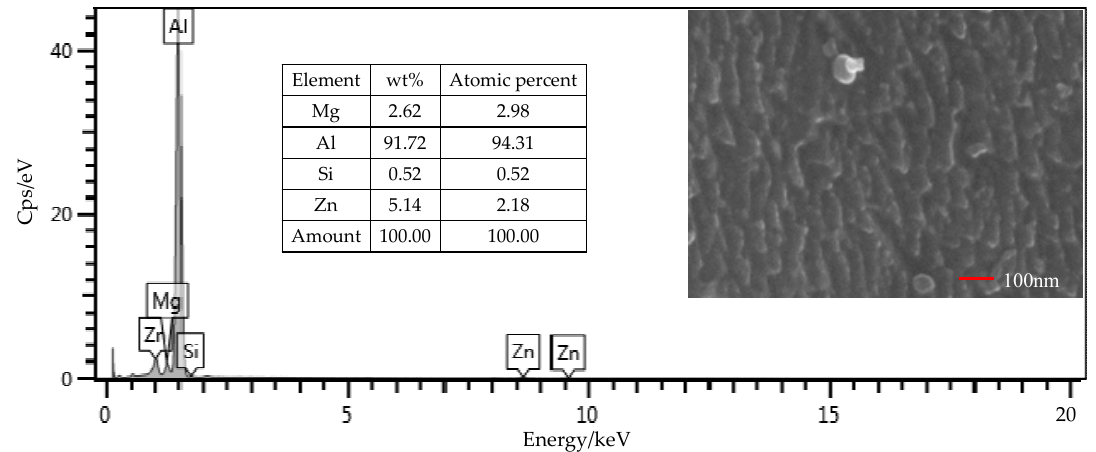
Figure 10. SEM and EDS test of the surface of the Al alloy sheet after the silanization treatment.